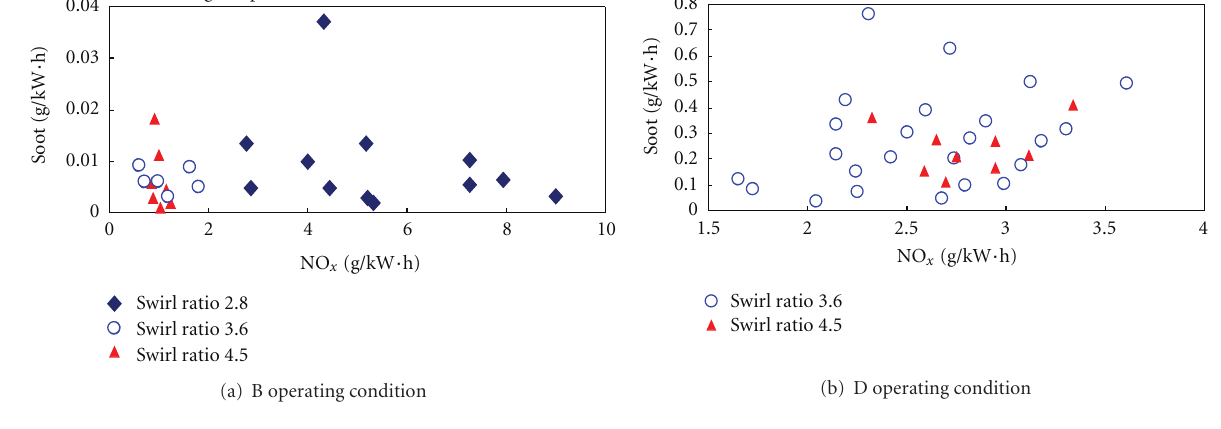
Figure 9: E ff ect of swirl ratio on NO x and soot emissions. Table 6: E ff ect of swirl ratio on engine performance.